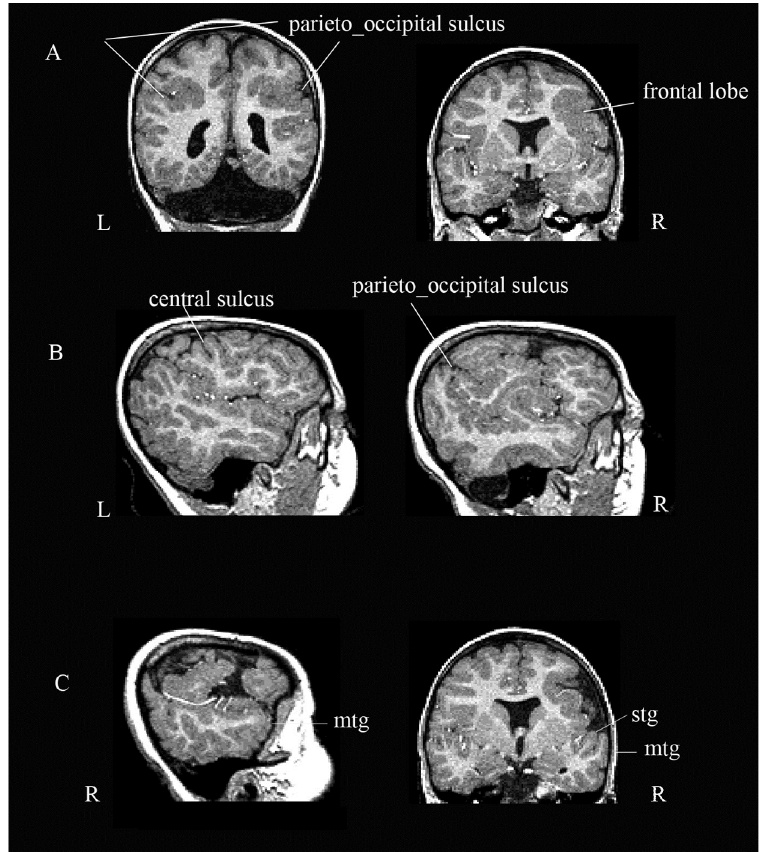
Figure 2. Cortical abnormalities. The figure shows the abnormal sulcation process with mis-location and mis-configuration of sulci and gyri. (Panel A ) shows abnormalities in both parietal lobes and the right frontal lobe. (Panel B ) shows polymicrogyria in the parietal lobes and the regions of the sylvian fissure bilaterally. (Panel C ) shows lateral and coronal views of the right temporal lobe; the medium temporal gyrus (mtg) is hiding the superior temporal gyrus (stg). L = left; R = right.